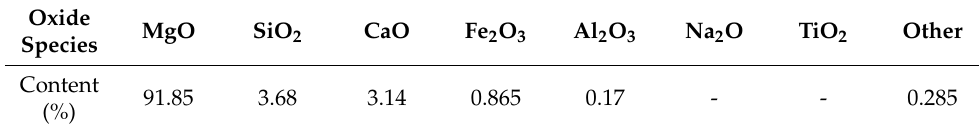
Table 1. Oxide composition of the dead burned magnesia powders.